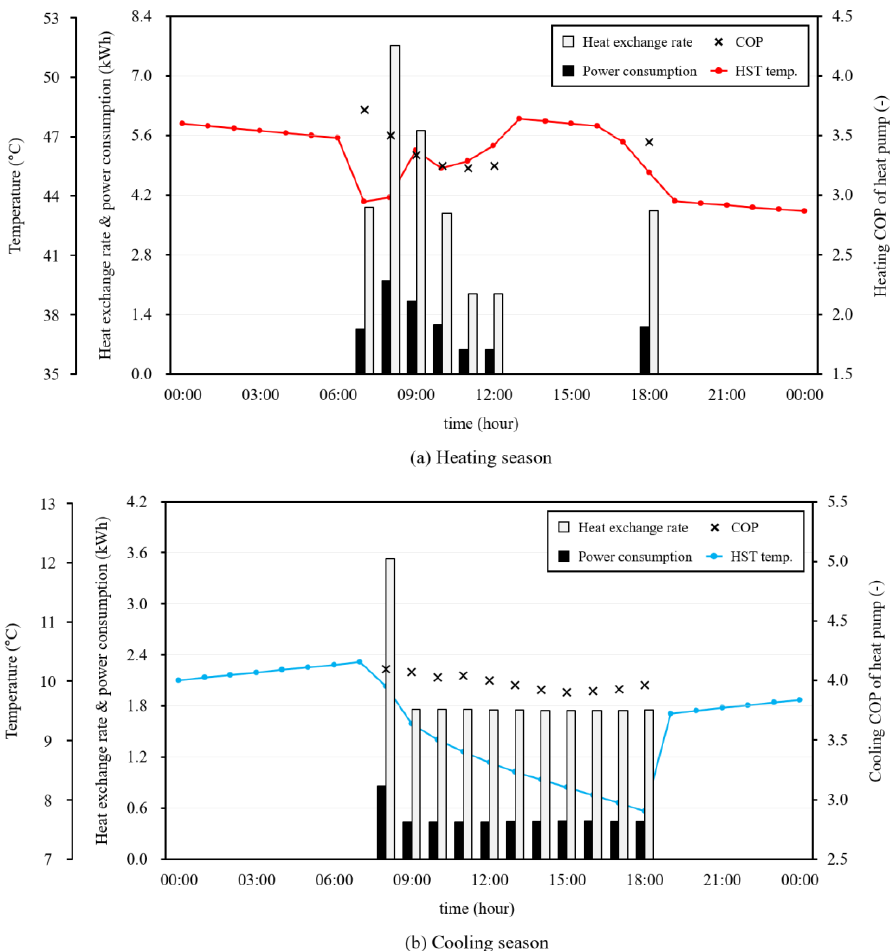
Figure 9. Coefficient of performance (COP) of the heat pump; ( a ) heating season, ( b ) cooling season.